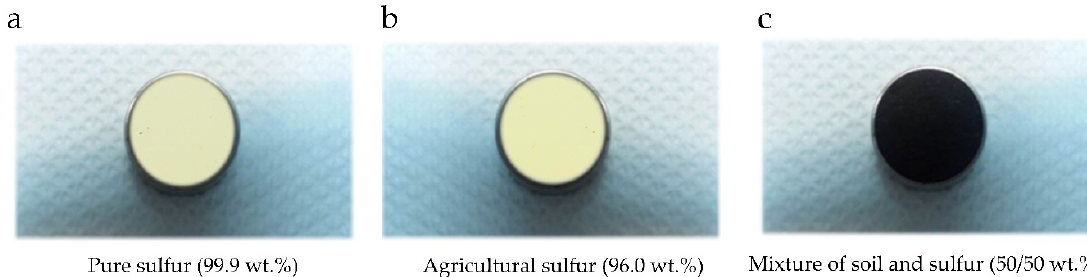
Figure 2. Samples prepared for the laser-induced breakdown spectroscopy (LIBS) measurements in the UV-ViS-NIR spectral region: ( a ) pure sulfur sample (99.9 wt.%), ( b ) agricultural sulfur (96.0 wt.%), ( c ) mixture of sulfur with organic soil (50/50 wt.%).